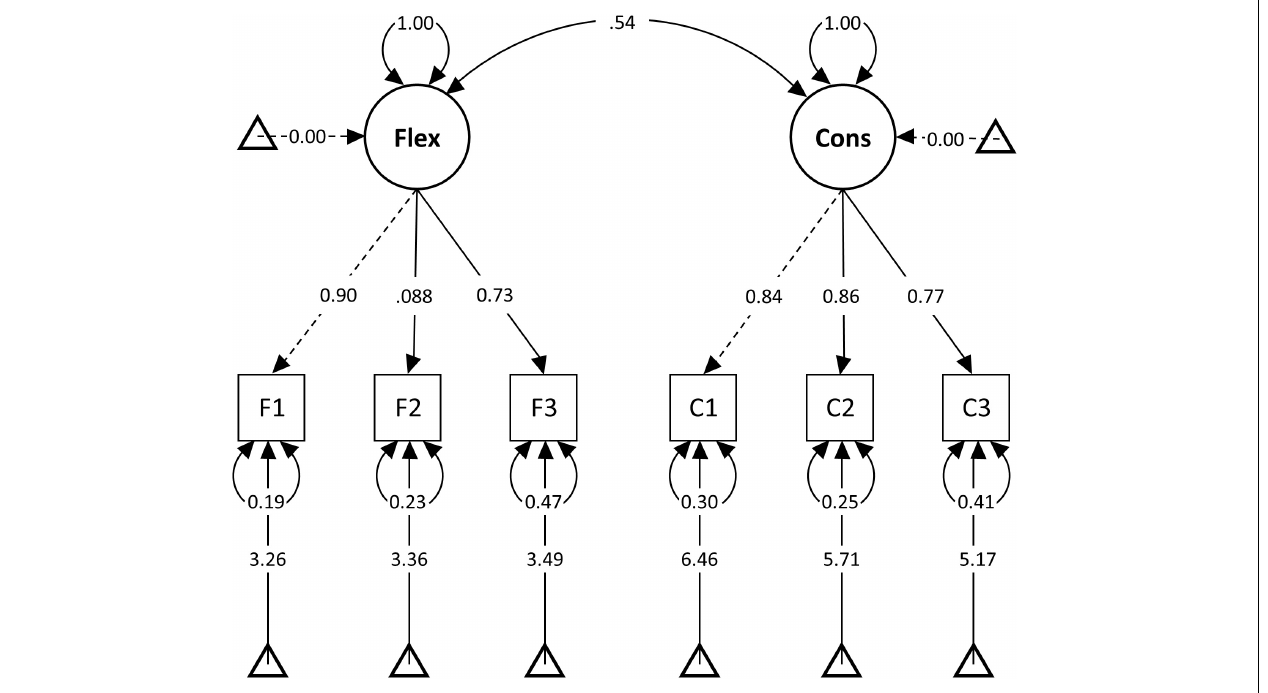
FIGURE 5 | Study 3: Measurement model for testing measurement